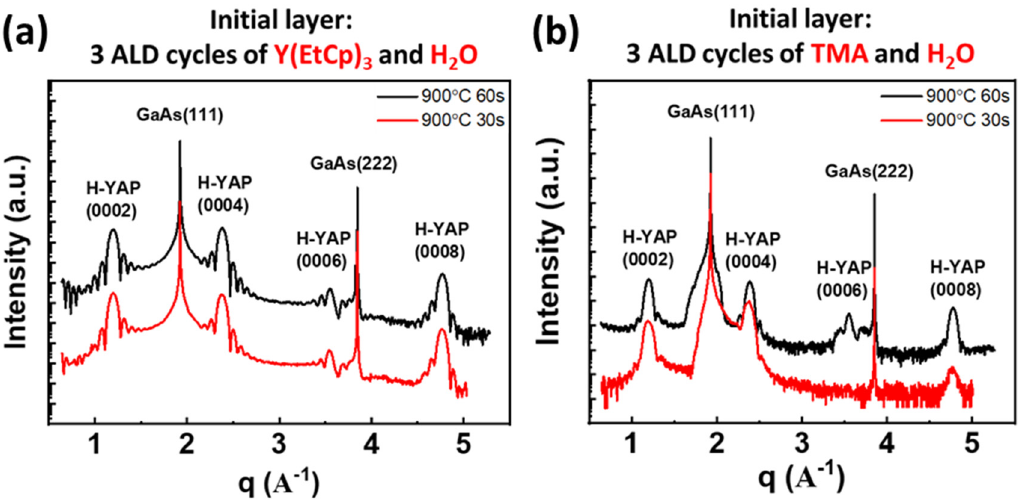
Figure 4. XRD radial scans along the surface normal of sample A ( a ) and sample B ( b ), both with 900 °C rapid thermal annealing (RTA) for 30 and 60 s.